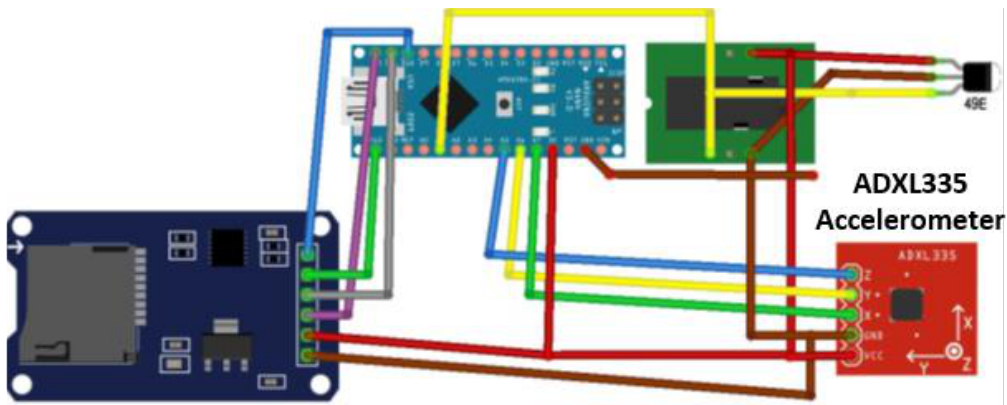
Figure 2. Component connection scheme.